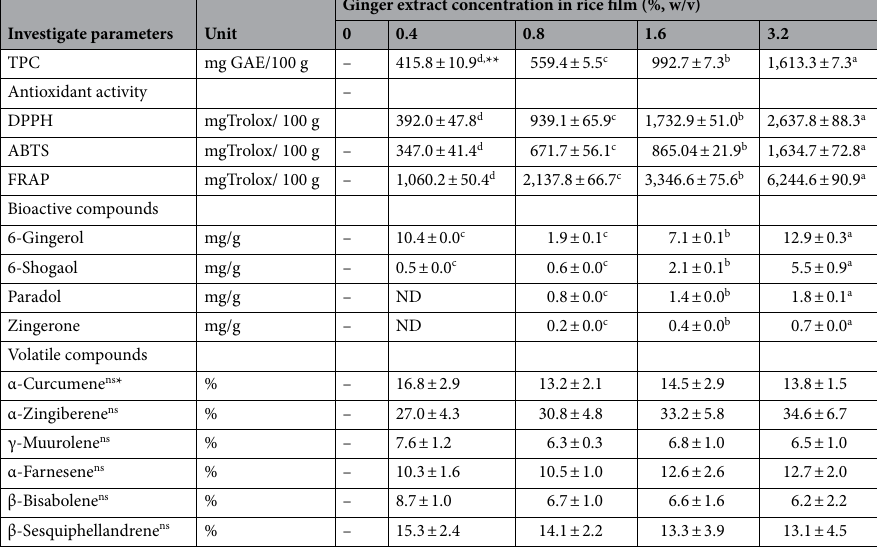
Table 5. Phenolic compounds, antioxidant activity, and volatile compounds in rice film strip incorporating various concentrations of crude ginger extract. *ns means not significant at p < 0.05. **a–d represented the significant difference in the rows at p <